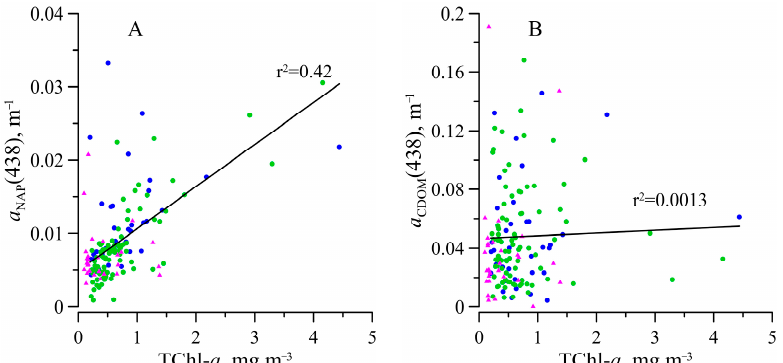
Figure 7. Effect of the sum of chlorophyll a concentration and phaeopigments (TChl- a ) on light absorption coefficients of non-algal particles ( a NAP ( 438 ) ) ( A ) and coloured dissolved organic matter at 438 nm ( a CDOM ( 438 ) ) ( B ). Symbol notations are the same as in Figure 5.